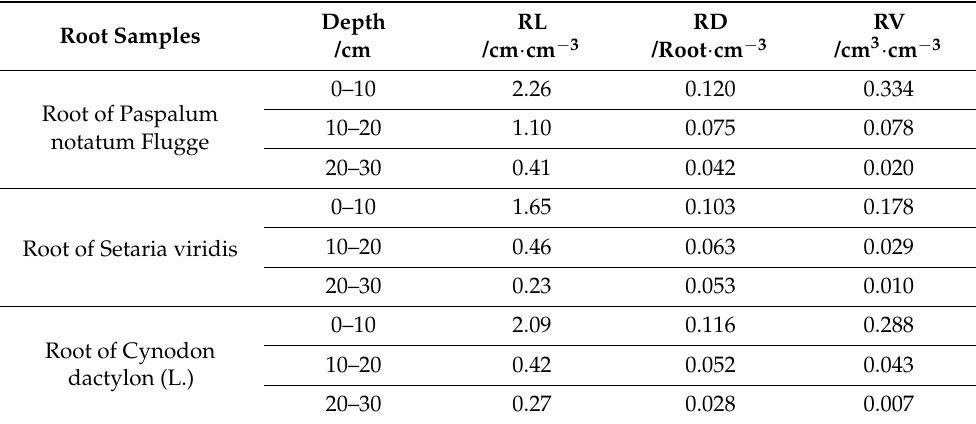
Table 4. Root system characteristic parameters.